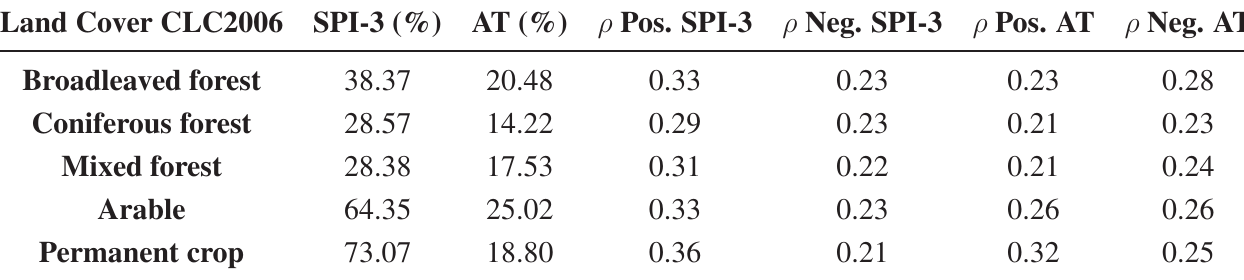
Table 1. Distribution of correlation over different land cover classes between FAPAR anomalies (AFAPAR) and rainfall (SPI-3) and temperature (AT) anomalies. neg., negative; pos., positive.